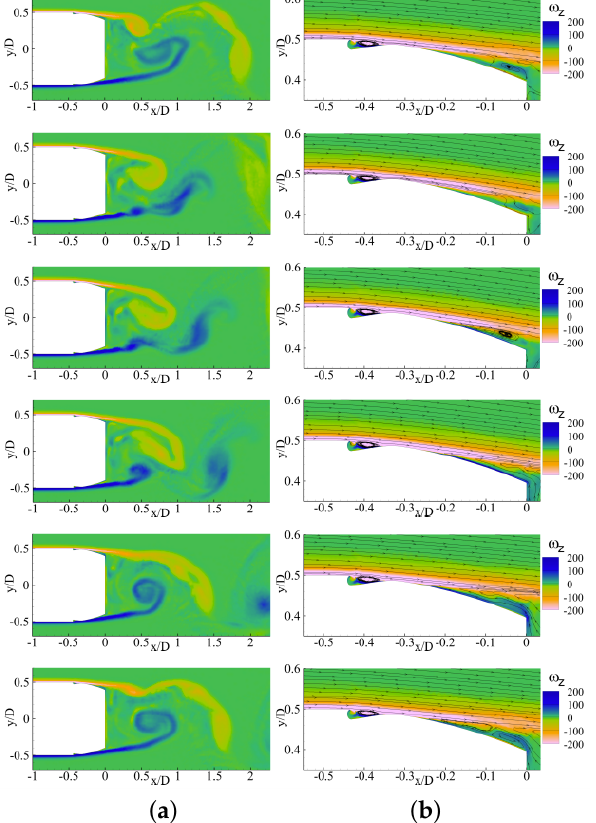
Figure 6. ( a ) Vorticity field during the vortex-shedding cycle and ( b ) on the lateral surface of the boat-tail y / D > 0. Time instants (from top to bottom): t / τ = 0, t / τ = 0.17, t / τ = 0.33, t / τ = 0.5, t / τ = 0.67 and t / τ = 0.83, τ being the vortex-shedding